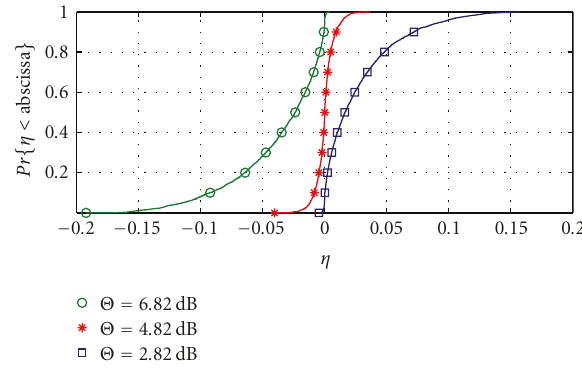
Figure 1: CDF of capture model error, η = P e , m − P loss